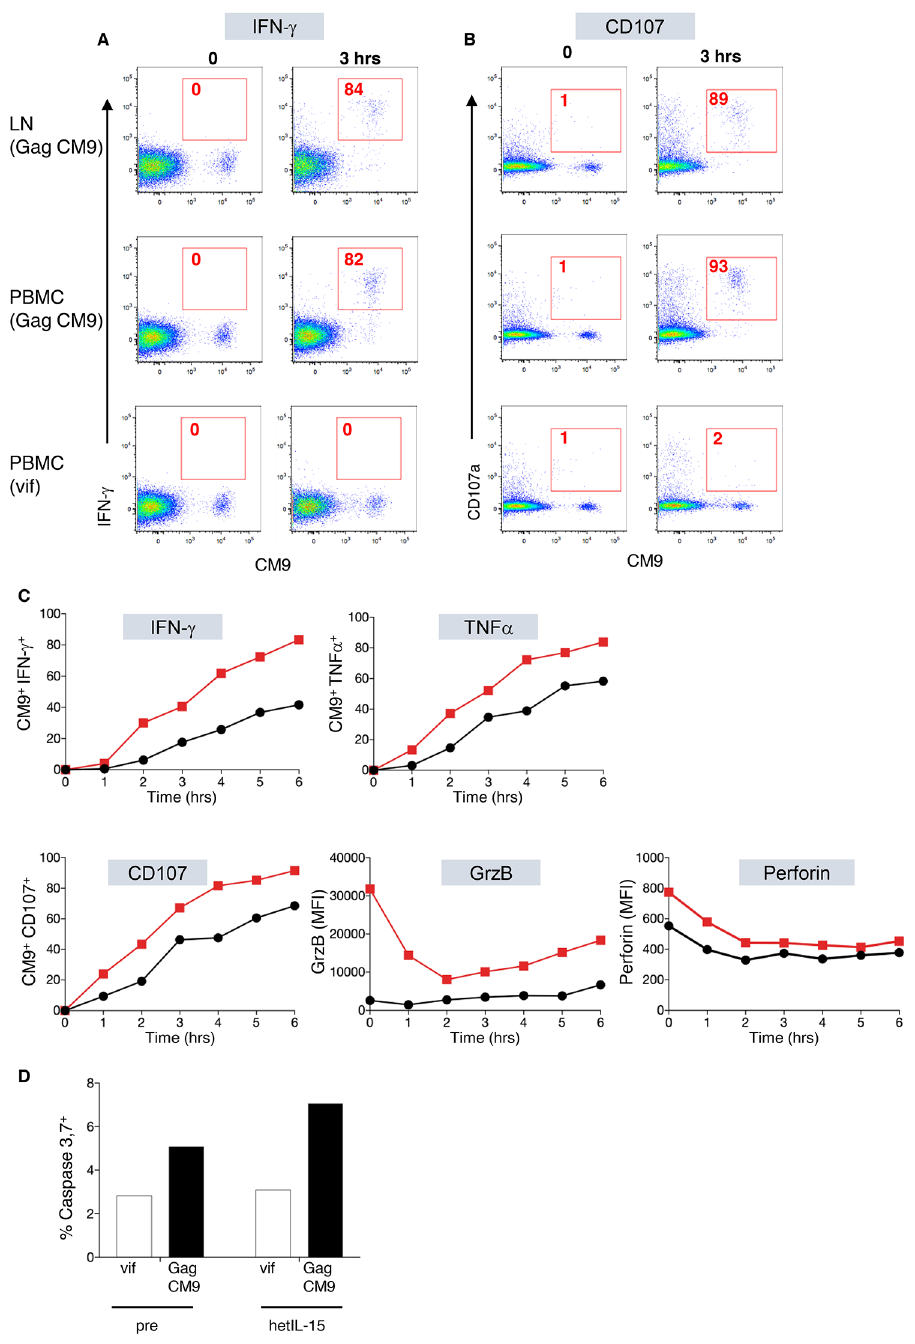
Fig 6. Functional assays for CM9-induced SIV-specific responses. Dot plots show production of IFN- γ (A) and degranulation CD107 (B) by CD8 + T cells specific for the MamuA01 restricted Gag CM9 epitope upon specific stimulation of the TCR with the CM9 peptide. The plots show the functional responses at 0 and 3 hours by lymphocytes from LNMC and PBMC of macaque P082. Similar data were obtained from macaque P090. (C) Time course showing the frequency of IFN- γ , TNF α and CD107 positive CD8 + CM9 + T cells in blood, as well as changes in their content of granzyme B and perforin after stimulation with the CM9 peptide in lymphocytes recovered before (black symbols) and after (red symbols) in vivo hetIL-15 treatment. Results in (C) are from a separate experiment with similar results to that shown in panels A and B. (D) Graph showing the frequency of bone marrow cells (macaque P090) loaded with the CM9 peptide or a peptide pool covering HIV-1 Vif undergoing apoptosis (measured as caspase 3 and 7 + cells) after incubation with LNMC obtained before and after hetIL-15 treatment.